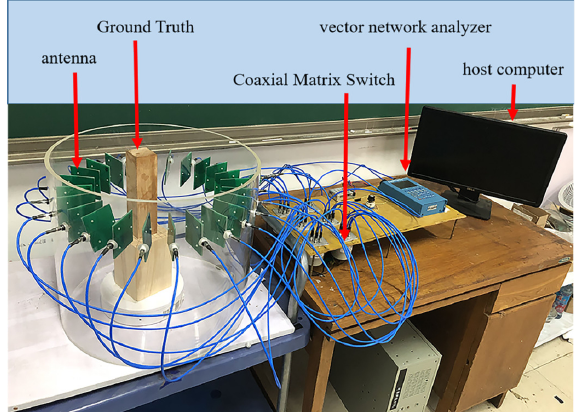
Figure 6. Microwave tomography system. 24 Vivaldi antennas were connected to a network analyzer via 6 Agilent Coaxial Matrix